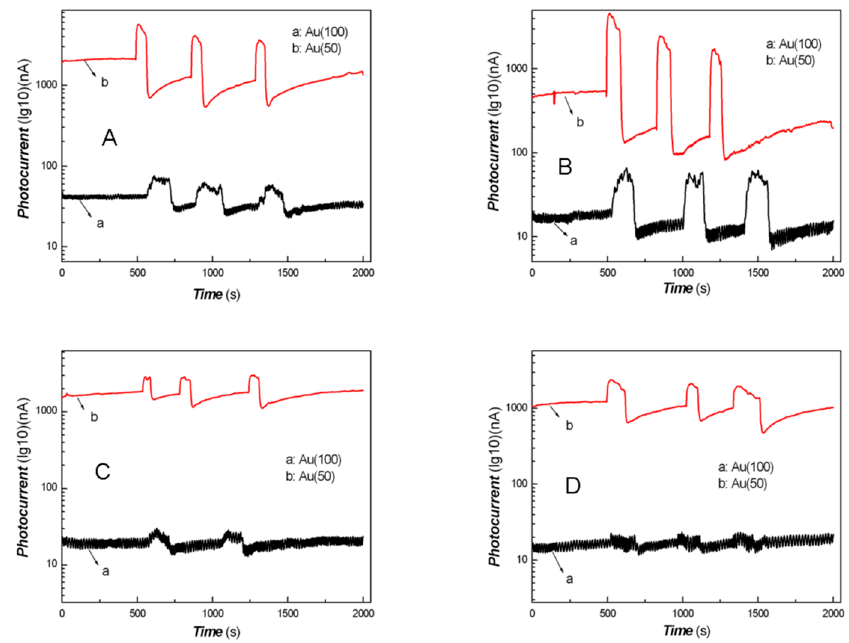
Figure 14. Photo-responses of Au/PANi nanocomposites functionalized with beta-cyclodextrin to 480 50 mW 780 nm, 808 nm, 980 nm and 1064 nm NIR. (A: 780 nm; B: 808 nm; C: 980 nm; D: 1064 nm) (a: 50 mW 780 nm, 808 nm, 980 nm and 1064 nm NIR. ( A : 780 nm; B : 808 nm; C : 980 nm; D : 1064